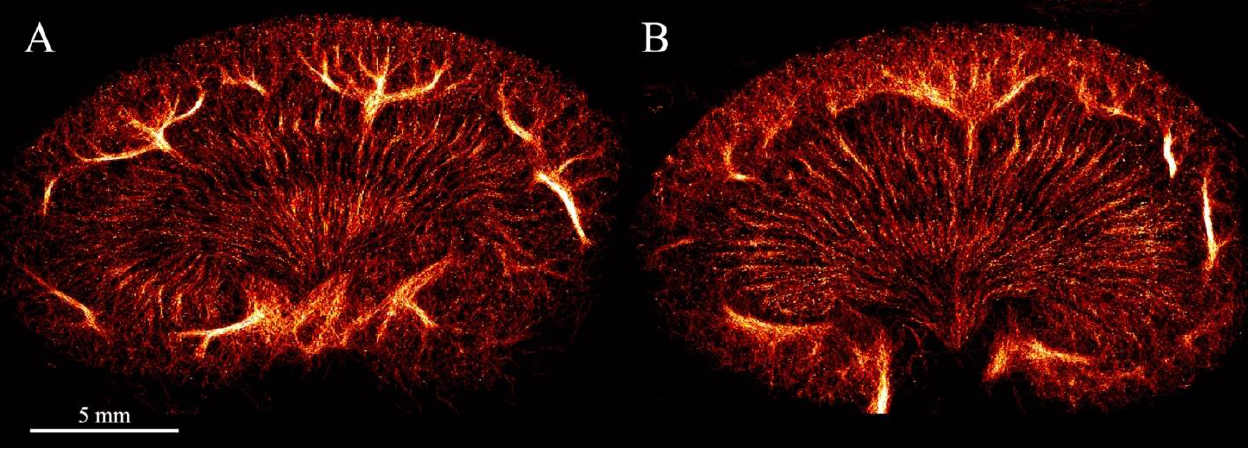
Figure 1. Super-resolution intensity images of the left kidney visualizing the renal vasculature from ( A ) a 20-week-old lean Zucker rat and ( B ) a 20-week-old obese Zucker rat giving an impression of increased density in the cortex with a more chaotic structure of the vessels. The intensity corresponds to the number of tracked microbubbles with a brighter color in the arcuate and segmental vessels compared with the less bright color in the vasa recta of the medulla and smaller vessels in the cortex.